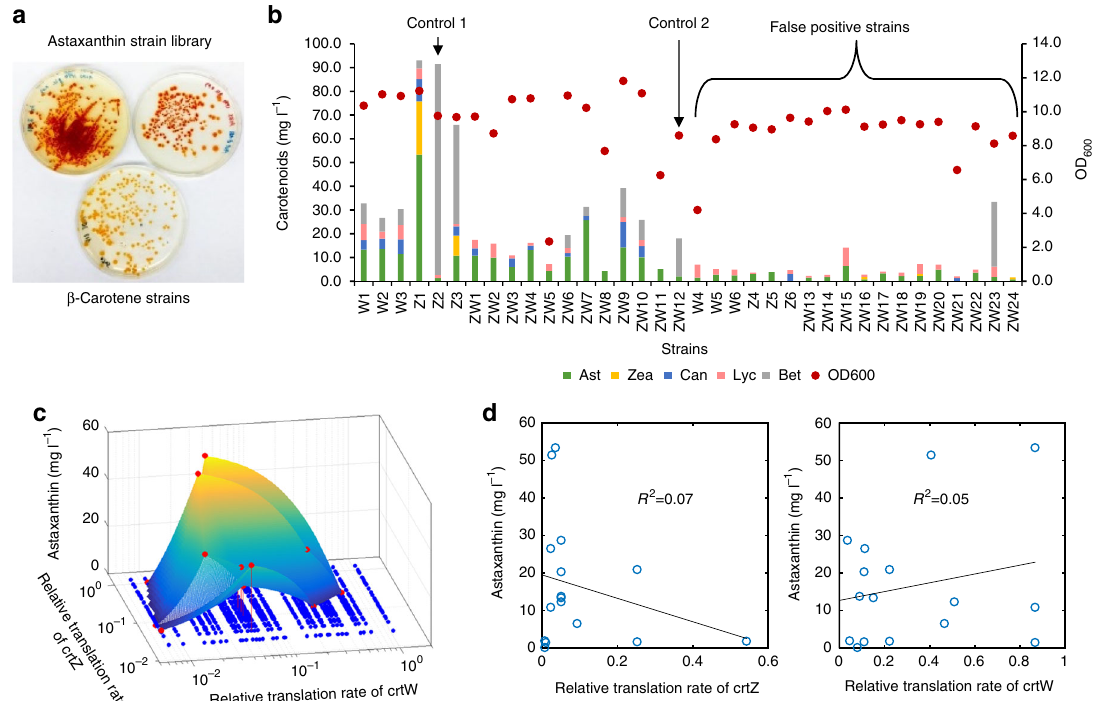
Fig. 5 Improving astaxanthin production using MHP. a Agar plates of astaxanthin strains (the two plates above were different astaxanthin strains) and parental β -carotene strains (the plate below with yellow colonies). b Titers and cell density of different strains chosen from library I, II, and III. Strains Z1-Z6 were picked colonies from library I ( crtZ RBS library), where Z2 was a yellow colony (control 1) and others were red colonies. Strains W1 – W6 were picked red colonies from library II ( crtW RBS library). Strains ZW 1 – 24 were picked colonies from library III ( crtZ and crtW RBS libraries), where ZW12 was a yellow colony (control 2) and the rest were red colonies. c The 3-dimensional correlation of astaxanthin production with the translation rates of crtZ and crtW . d Scatterplot of astaxanthin production and RBS strength of crtZ or (Supplementary Table 5). The results con fi rmed that colorimetry of culture media (or extracellular astaxanthin) was a more ef fi cient screening approach for astaxanthin biosynthesis than the common colony screening.